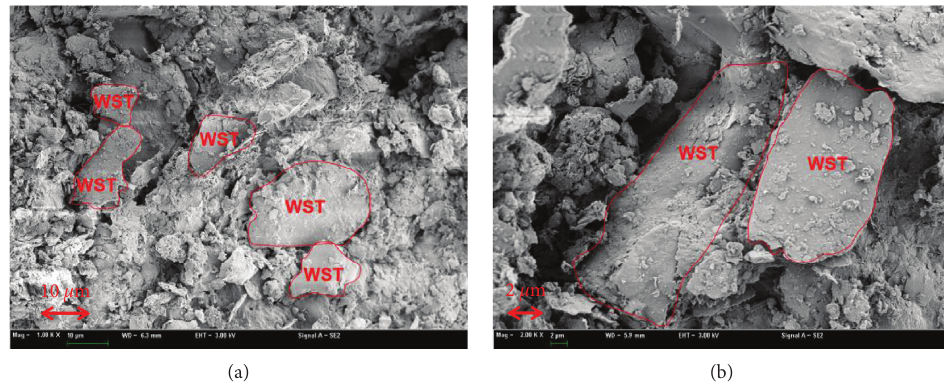
Figure 7: SEM images of WST-clay composite after compression test zooming at different scales.